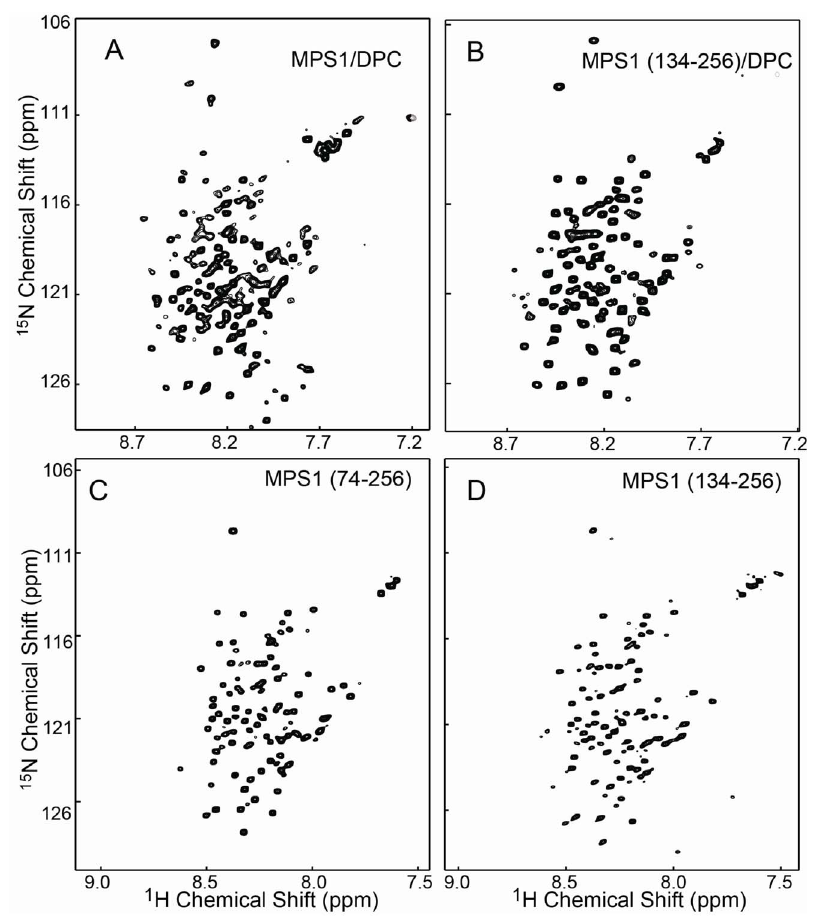
Figure 2. Two-dimensional 1 H- 15 N HSQC spectra of 15 N labeled full-length and truncated MPS-1 under different buffer conditions at 25 6 C. (A) Full-length MPS-1(1–256) spectrum in DPC micelles; (B) MPS-1(134–256) spectrum in DPC micelles; (C) MPS-1(74–256) spectrum in aqueous buffer; (D) MPS-1(134–256) spectrum in aqueous buffer.